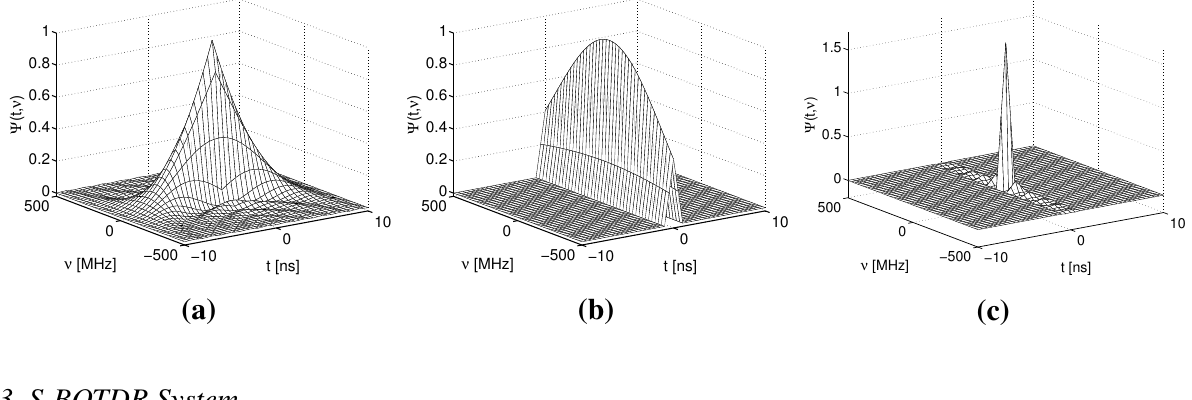
= 1 ns; and D = 50 1 2